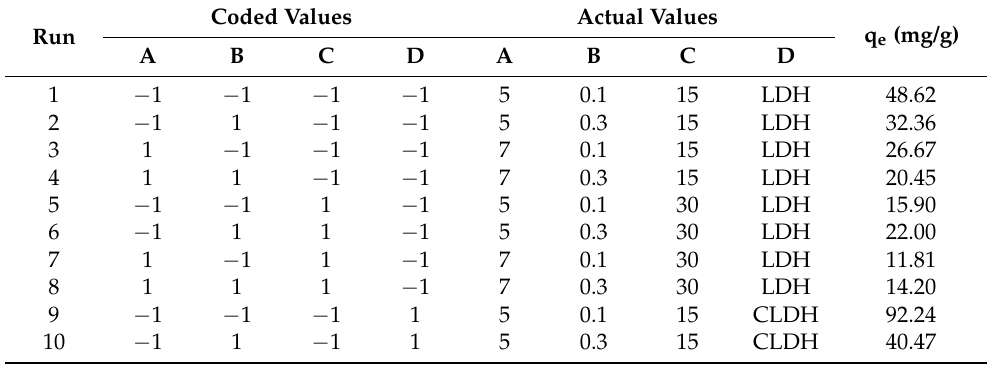
Table 6. Factorial experimental design matrix in coded and real values and experimental